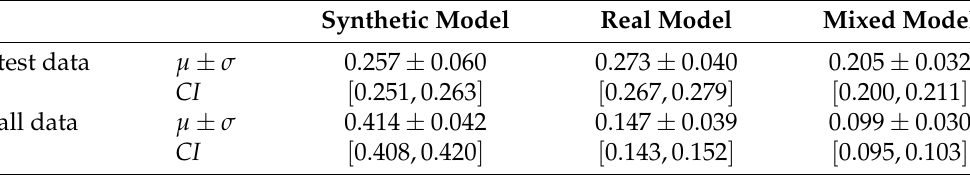
Table 1. Evaluation results for crack classification of three models based on (i) synthetic data, (ii) real data, and (iii) mixed data. Shown is the mean error ± standard deviation of each model for the real data test set and for all real data. Additionally, the 99% confidence intervals for each setup are shown. The results are based on 200 independent training runs. Furthermore, we computed a two-tailed paired t -test for real versus mixed model on the real test data ( p -value = 2.16 × 10 − 47 ) and on all real data ( p -value = 1.24 × 10 − 32 ), which rejects the null hypothesis that the corresponding means are equal significantly. µ ± σ = mean error ± standard deviation, CI = confidence